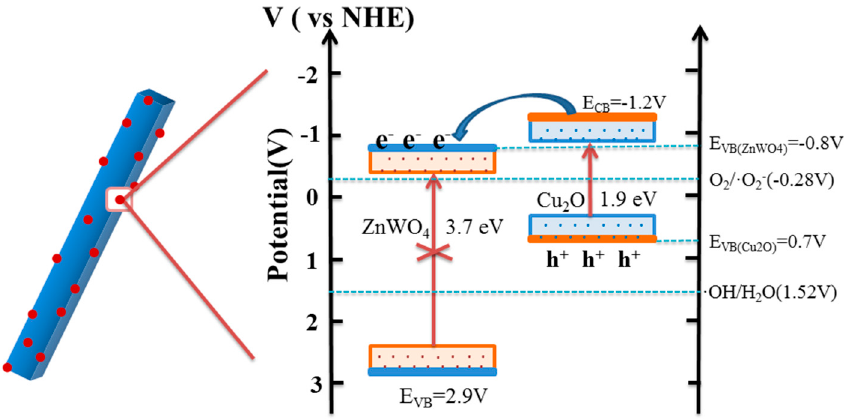
Figure 12. Schematic illustration of photo-generated carriers’ transportation for Cu 2 O/ZnWO 4 composite.